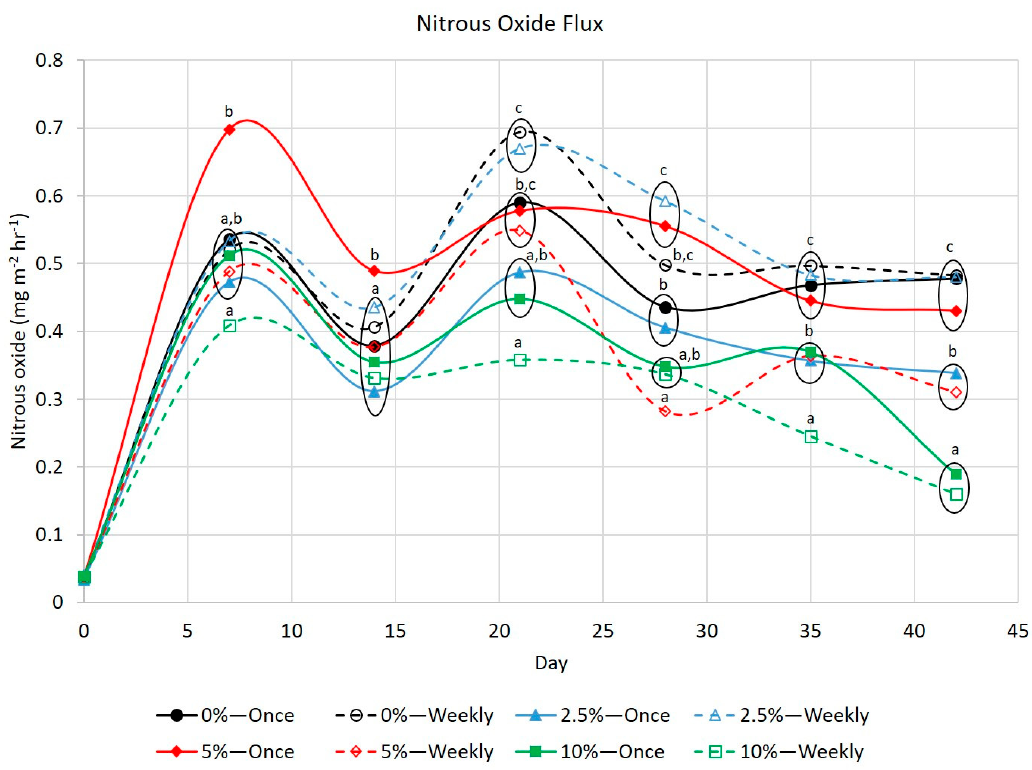
Figure 4. Average nitrous oxide flux (mg m − 2 h − 1 ) for weekly measurements taken over 42 days for bedded packs treated with 0, 2.5, 5, and 10% alum either in one dose or in weekly doses. Alum × Dose × Day interaction p < 0.01, pooled standard error of the mean = 0.05. Clusters with different letters indicate significant differences p < 0.05 .